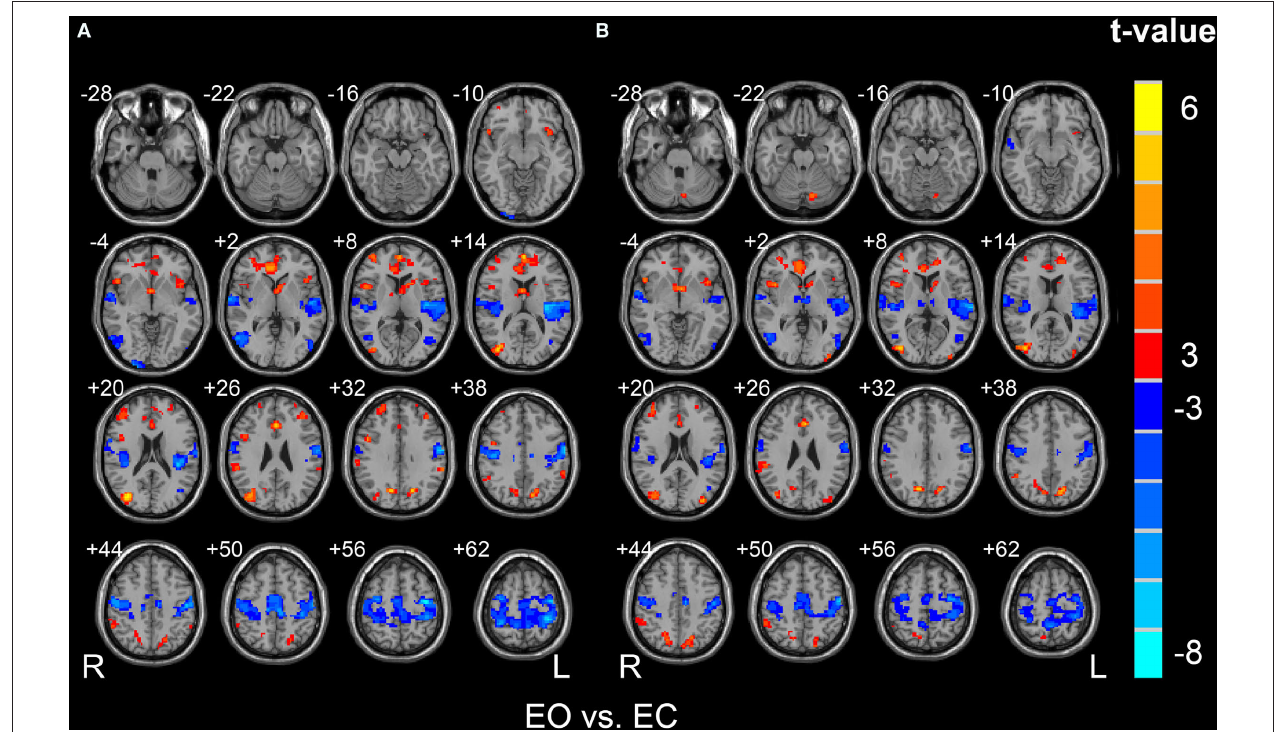
FIguRe 4 | Brain regions showing significantly different Cohe-ReHo (A) and KCC-ReHo (B) between eO and eC resting states. The left side of the image corresponds to the right side of